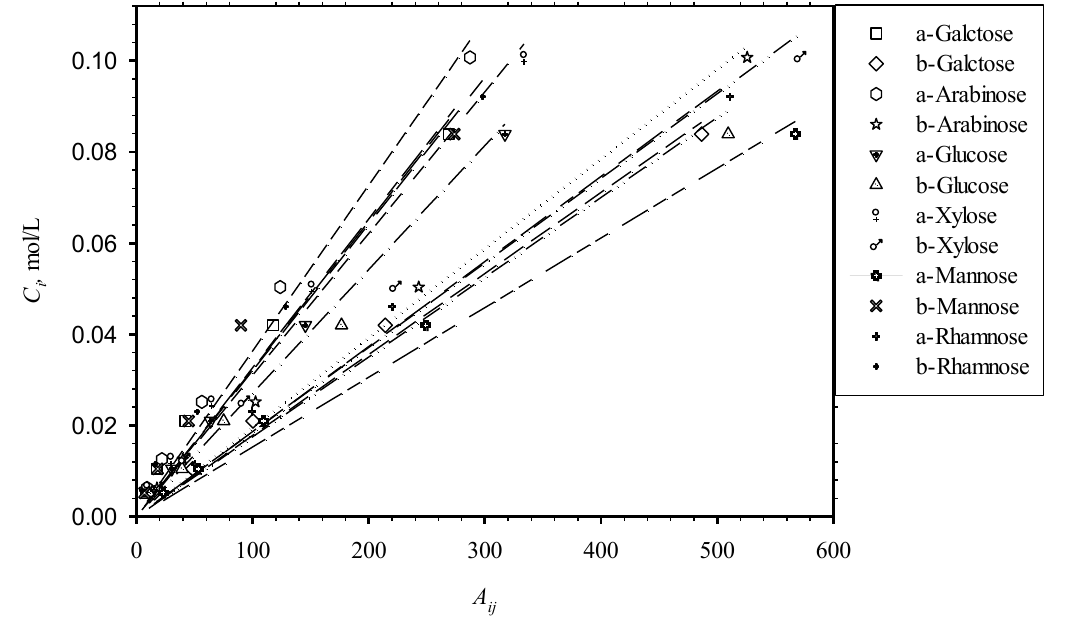
Figure 2. Standard curves for 2D-HSQC [30]. C i is the mole concentration of species i and j designations the functional group (C1H1) identified by NMR belonging to species i . A ij is the 2D-HSQC resonance integral for the j functional group of species i